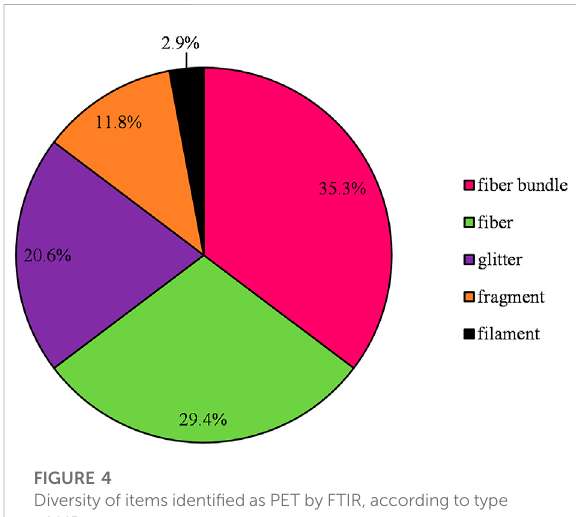
FIGURE 4 Diversity of items identi fi ed as PET by FTIR, according to type of MPs.